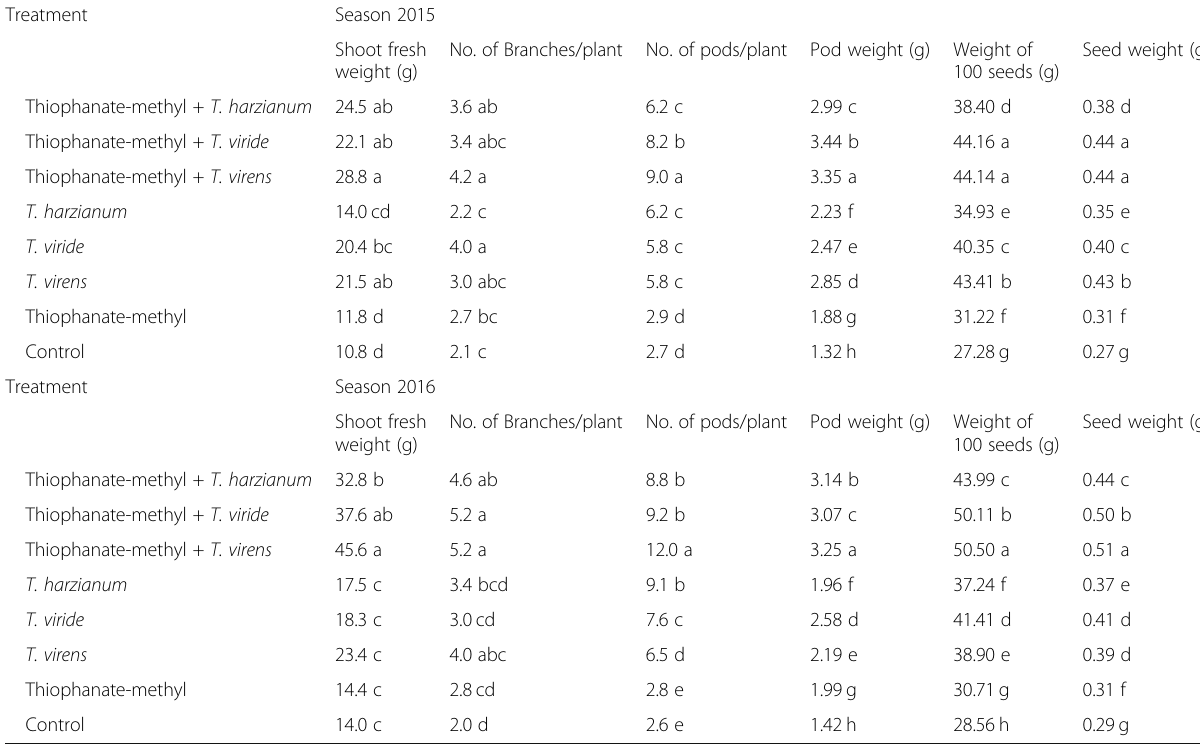
Table 4 Effect of soil application with Trichoderma spp. and seed coating with thiophanate-methyl employed either alone or in combination on growth parameters and yield components of dry bean grown under field condition